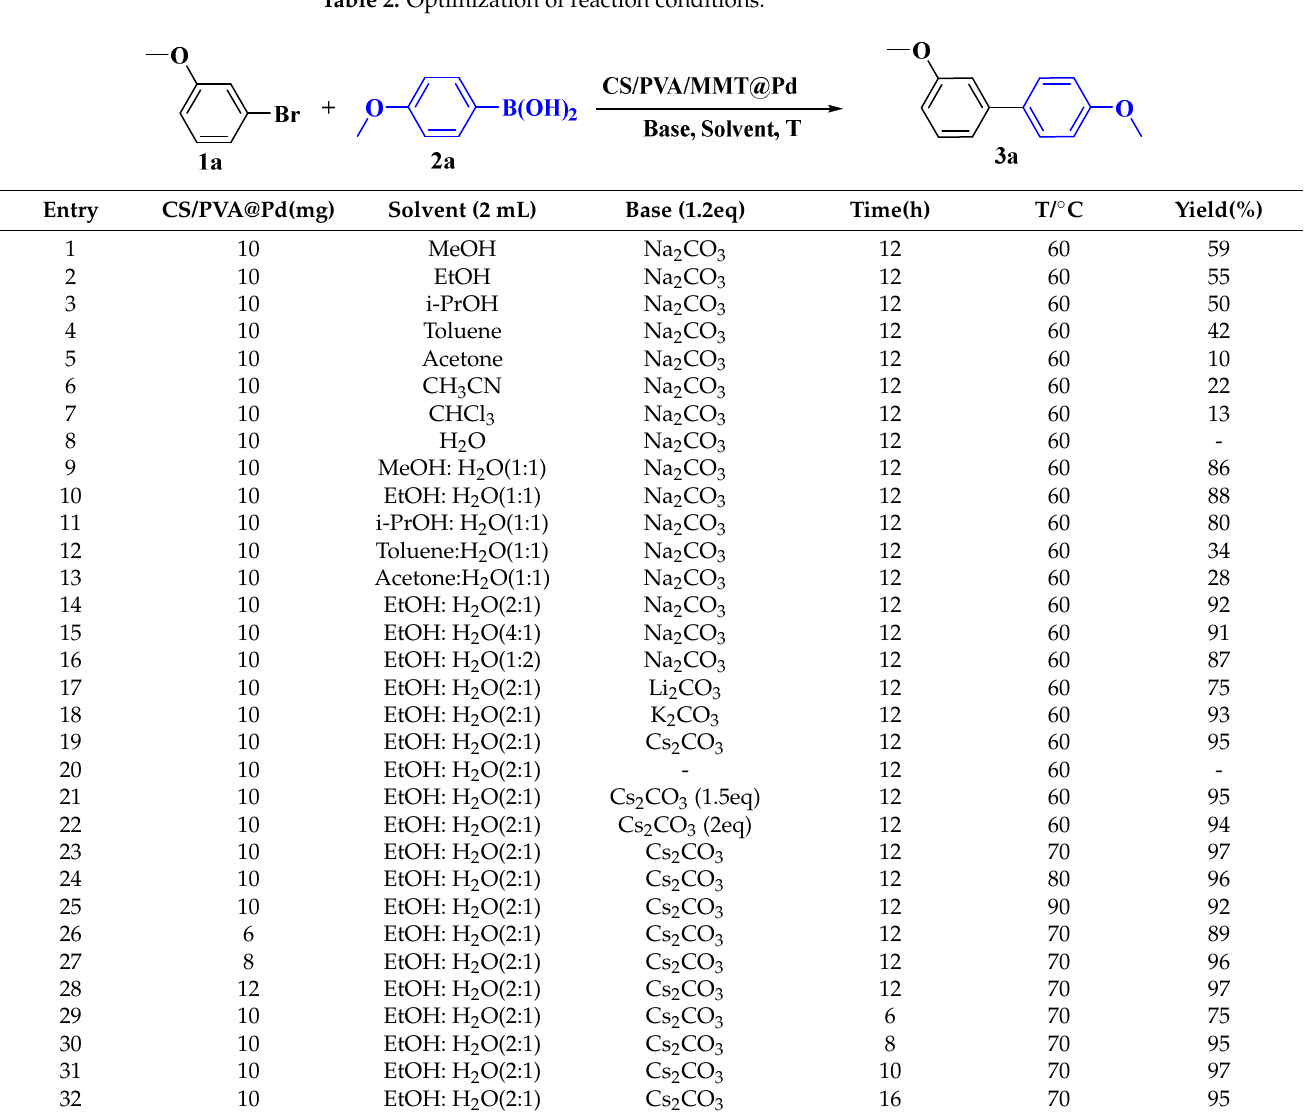
Table 2. Optimization of reaction conditions.